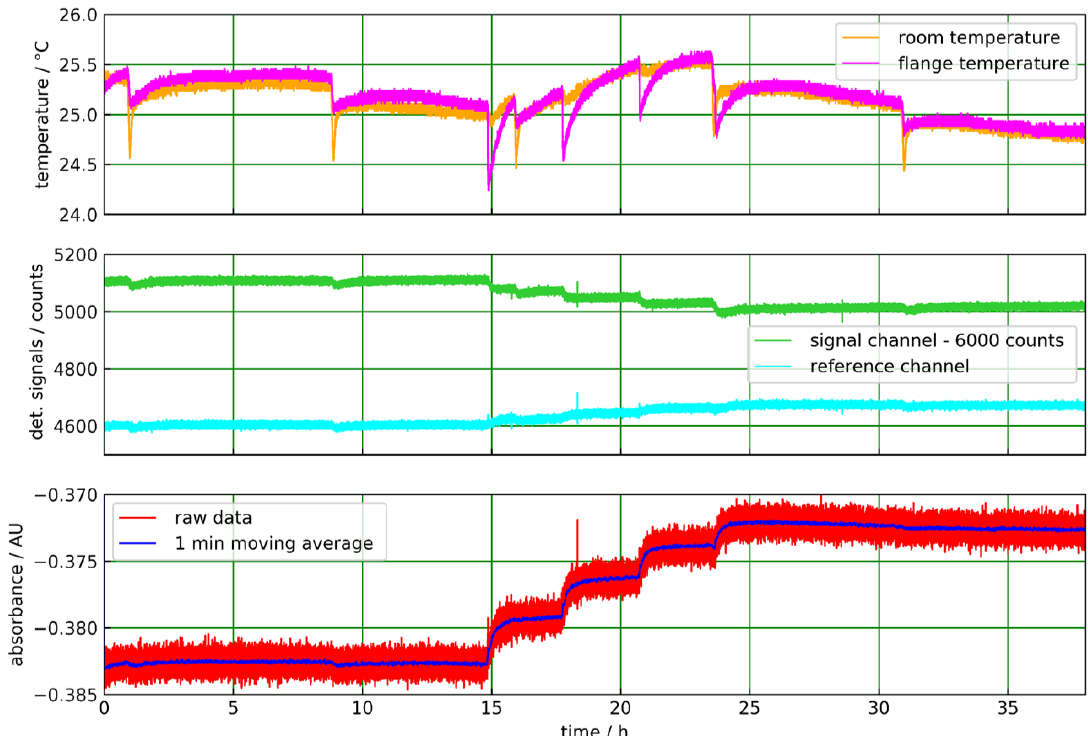
Figure 8. ATR measurement of acetonitrile in isopropanol with the sapphire tube in transmission geometry. The ambient and flange temperatures show distinct dips, which occurred when liquid was added to the sample reservoir ( top ). The signal and reference channel data are slightly affected by these events. Concentration steps (0%, 5%, 10%, 15%, 20% (m/m) acetonitrile in isopropanol) are clearly visible in the signal channel but also in the reference channel, which shows an increasing level at higher acetonitrile concentrations ( middle ). In the absorbance plot the concentration steps are clearly resolved ( bottom ).